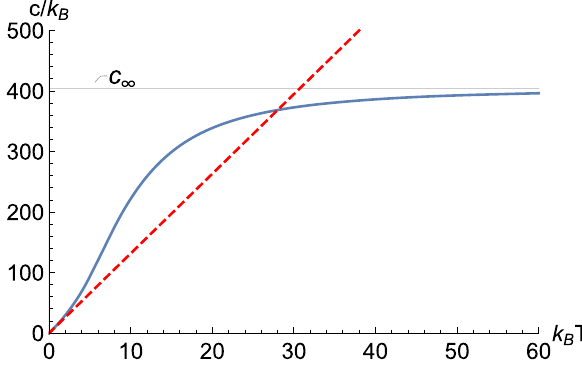
Fig. 1 Comparison of the specific heat capacity c ( T ) with β = 0 . 2375 in the two cases: classical dispersion relation in the continuum (red, dashed), modified dispersion relation for (cid:2) = 0 . 015 (blue, solid). In contrast to the continuum model, the specific heat capacity of gravitons in the discrete approaches a constant c ∞ for T → ∞